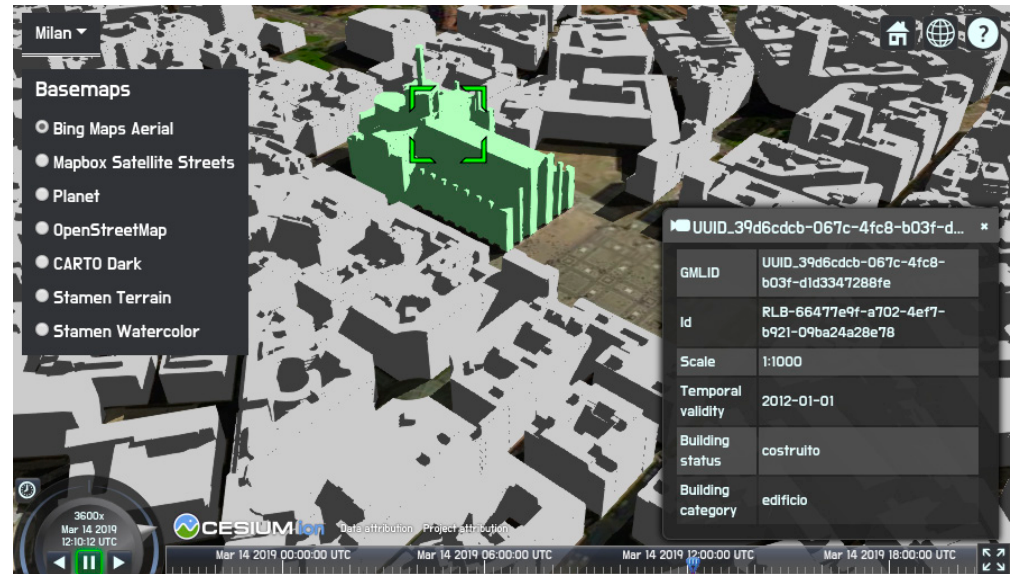
Figure 8. Visualization and query of the 3D model of the city of Milan [79].